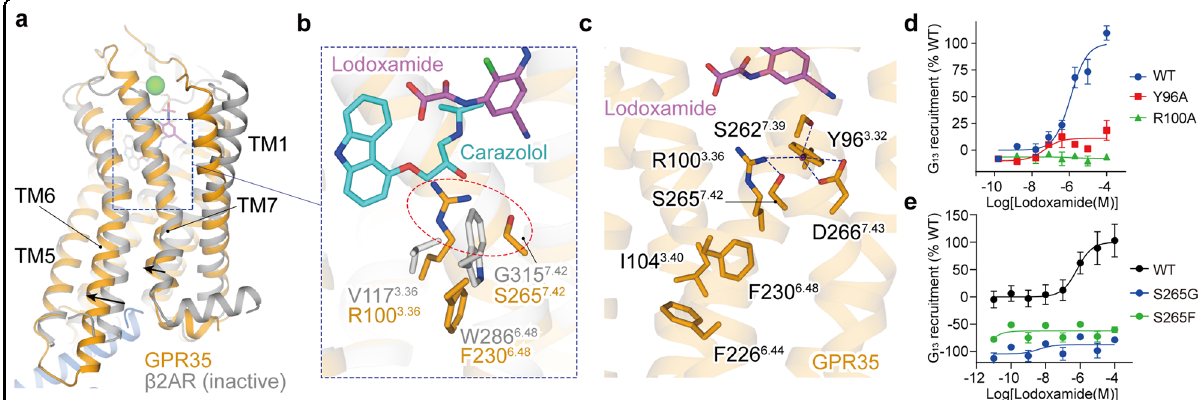
Fig. 4 Activation mechanism of GPR35 by lodoxamide. a Structural superposition of GPR35 with the inactive β 2 AR. The movement directions of TM6 and TM7 of GPR35 (orange) relative to the inactive β 2 AR (grey, PDB: 2RH1) are indicated by black arrows. b The potential steric hindrance, caused by R100 3.36 and S265 7.42 , pushes F230 6.48 moving downward. The potential steric hindrance is highlighted in a red dashed circle. c The polar interaction network at the bottom of the ligand-binding pocket of GPR35 and the gain-of-inter-helical hydrophobic contacts between F230 6.48 and two conserved PIF residues, I104 3.40 and F226 6.44 . d , e Effects of mutation of residues in the polar interaction network on lodoxamide-induced G 13 recruitment by